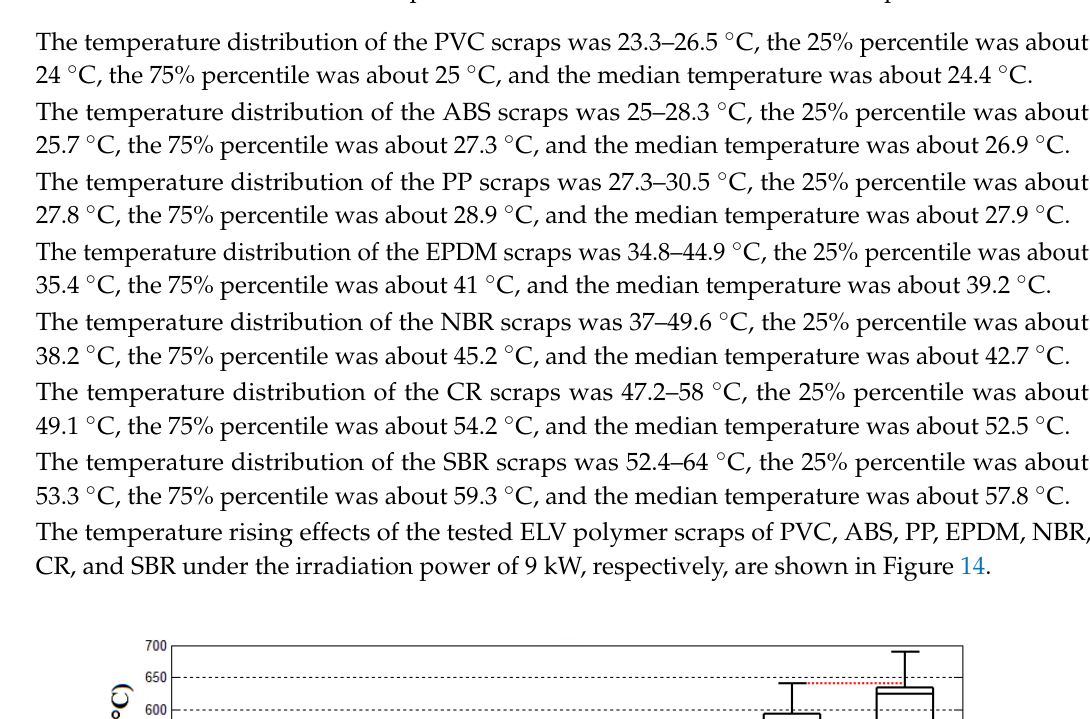
Figure 13. Distribution of temperature rises on tested polymer samples under microwave irradiation power of 6 kW.